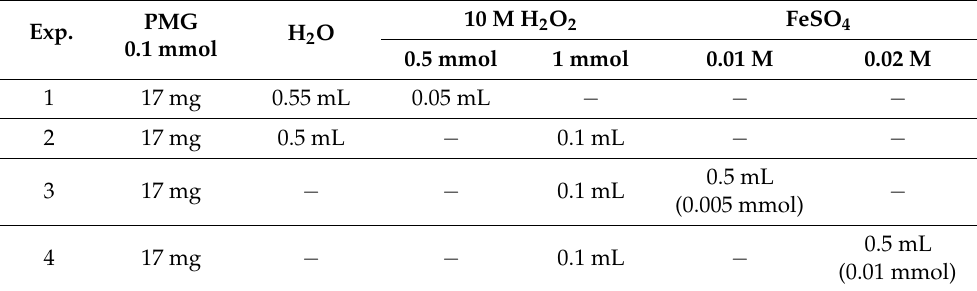
Table 3. Preparation of the reaction mixtures for PMG-H 2 O 2 and PMG-H 2 O 2 -Fe 2+ systems.